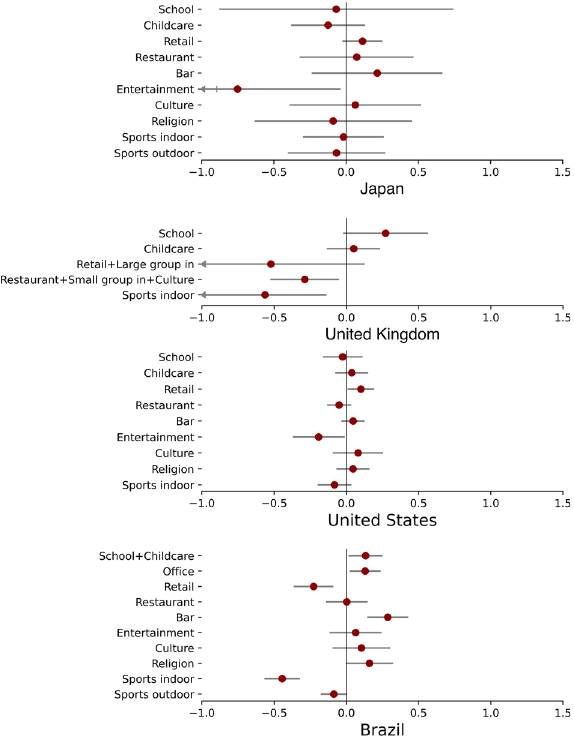
Fig. 2 Estimated impacts of closing individual types of establish- ments. The numbers are direct model outputs on the relationship between establishment status (0, 0.5, or 1) and Δ log(R t ) . Full results are presented in Supplementary Table 2. The error bars represent 95% con fi dence